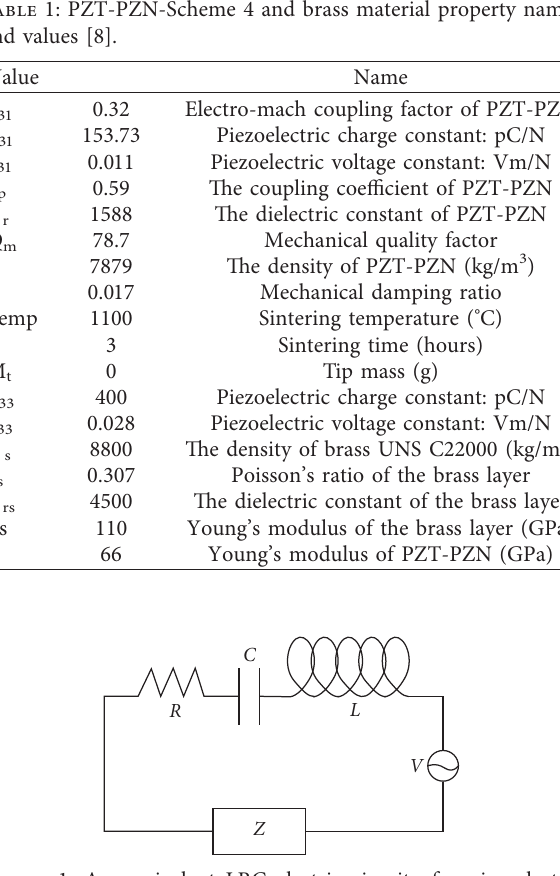
Figure 1: An equivalent LRC electric circuit of a piezoelectric bimorph energy